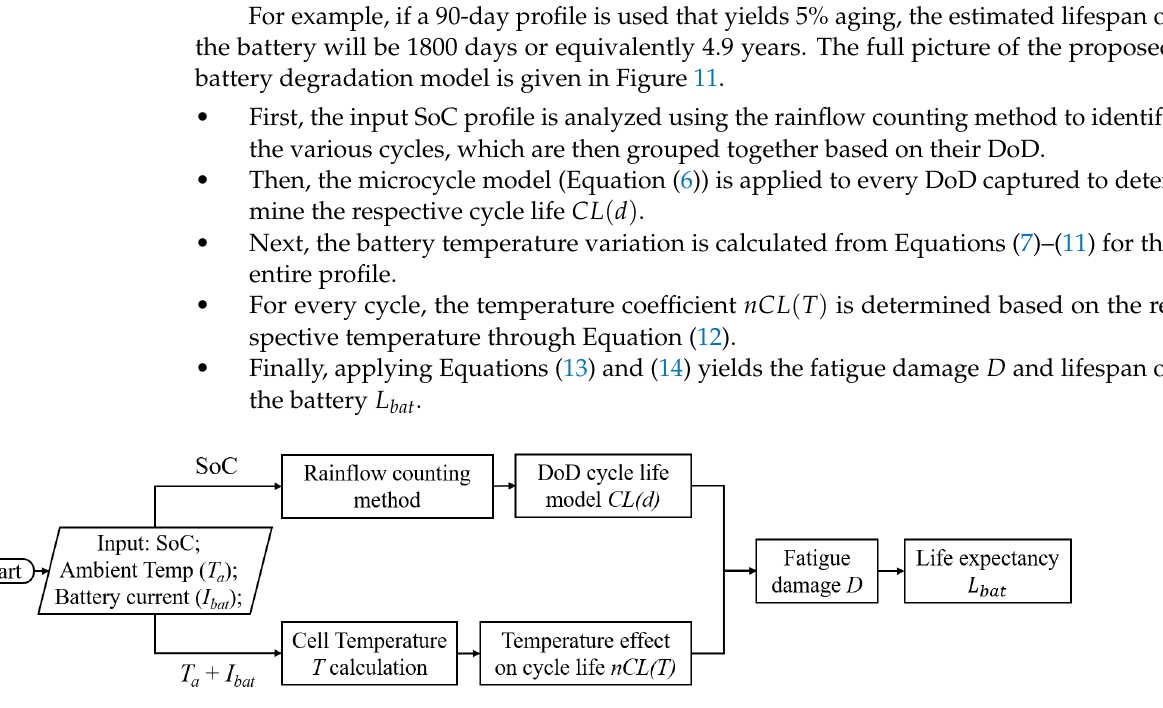
Figure 11. Flowchart of the proposed battery life estimation